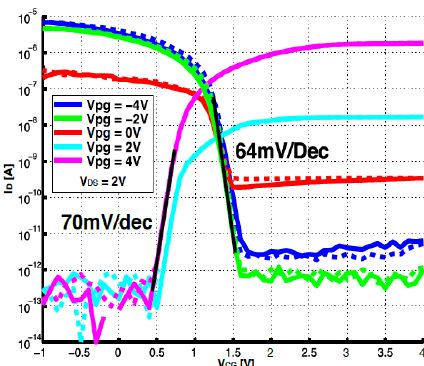
Figure 12. The drain current versus gate ‐ source voltage. Reproduced with permission from [36], Copyright IEEE, 2012.